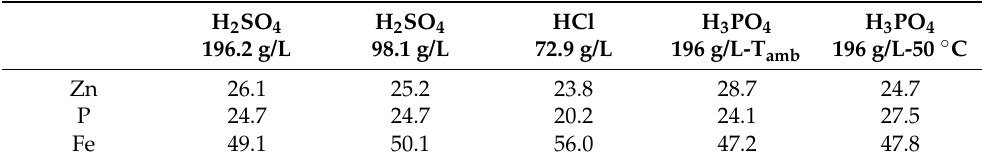
Table 4. Quantitative EDS analysis (atomic%) of the phosphate layers obtained after the several pickling